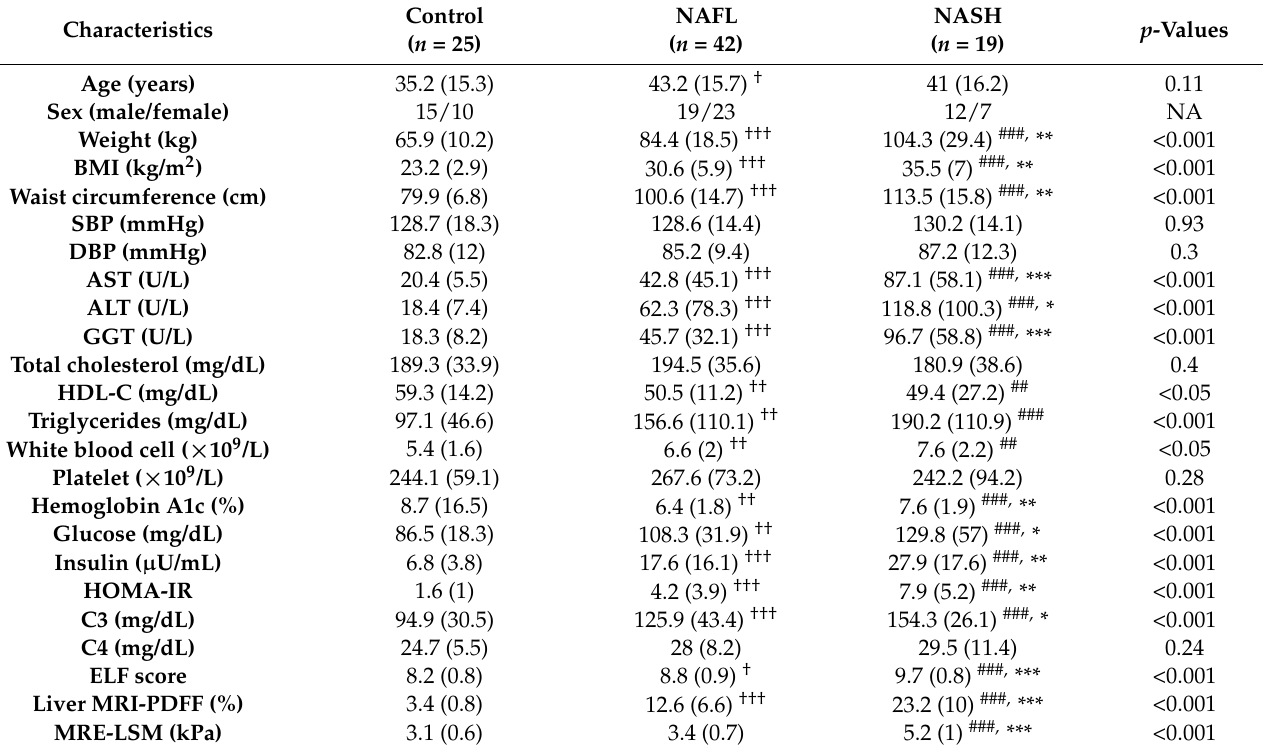
Table 1. Demographic and clinical characteristics of the study